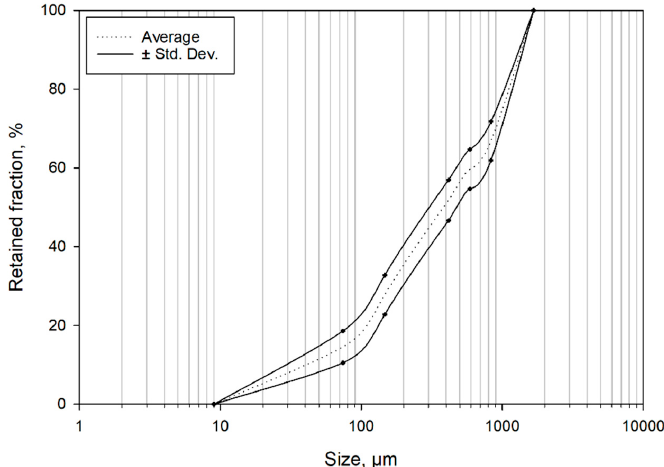
Figure 2. Average particle size distribution of the drill-holes. Based on 5 kg increment samples.